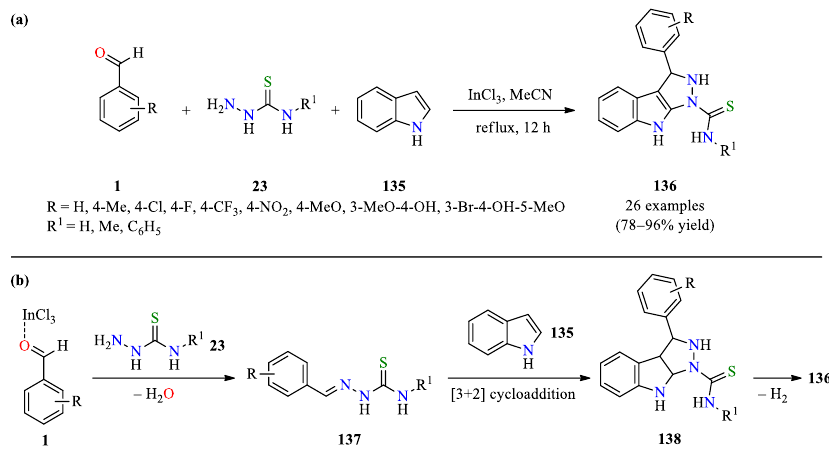
Scheme 18. ( a ) Three-component synthesis of fused indolo-pyrazoles 136 for evaluation of their an- tifungal activity, ( b ) plausible mechanism for the synthesis of compounds 136 . Table 40. Antifungal activity of spiropyrrolidine-oxindoles 29